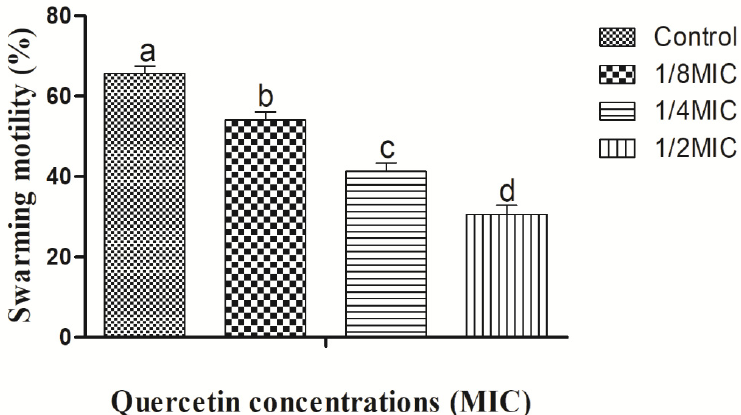
Figure 2. Swimming motility assay for Vibrio parahaemolyticus with sub-MICs of quercetin (µg/mL). Data are represented as mean ± SEM of three independent replicates. a–d Values with different letters differ significantly different by Duncan’s multiple-range test ( p < 0.05).